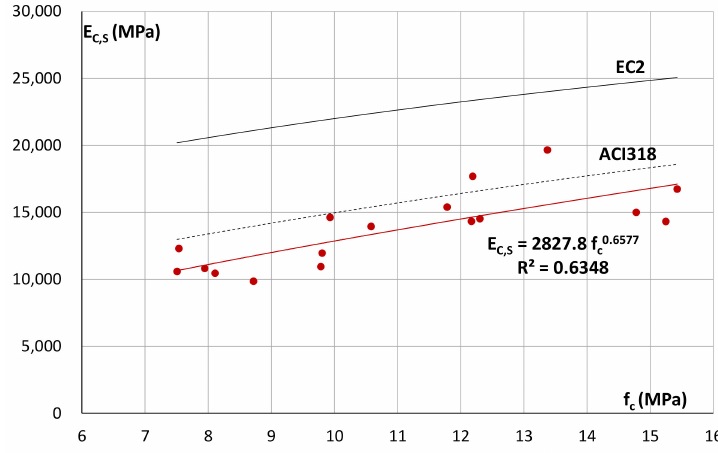
Figure 2. Correlation law between E C,S an f c (comparison with the